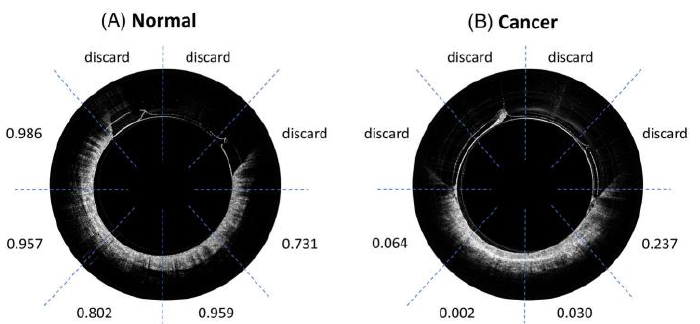
Figure 16. ( A ) ResNet prediction of OCT endoscope image of the normal region and ( B ) OCT endoscope image of the cancerous region. Reprinted with permission from [200]. Copyright 2022 John Wiley and Sons: Journal of Biophotonics.